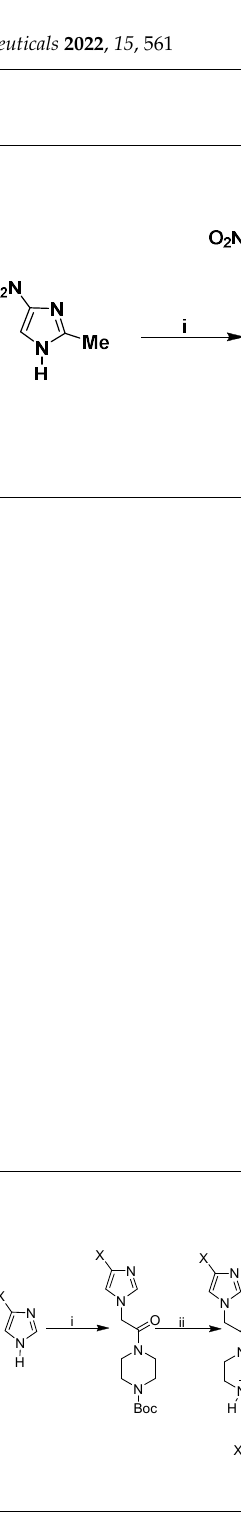
Scheme 28. Synthesis of 4-nitromidazole as dye conjugates. Reagents and conditions: ( i ) tert -butyl-4- (2-bromoacetyl) piperazine-1-carboxylate, NaH, DMF, 0 ◦ C-rt, 12 h, 67% and 76%; ( ii ) CF 3 COOH, CHCl 3 , 0 ◦ C-rt, 61% and 74%; ( iii ) DMF, 0 ◦ C, pyBop, HOBt, rt, 12 h, 15% and